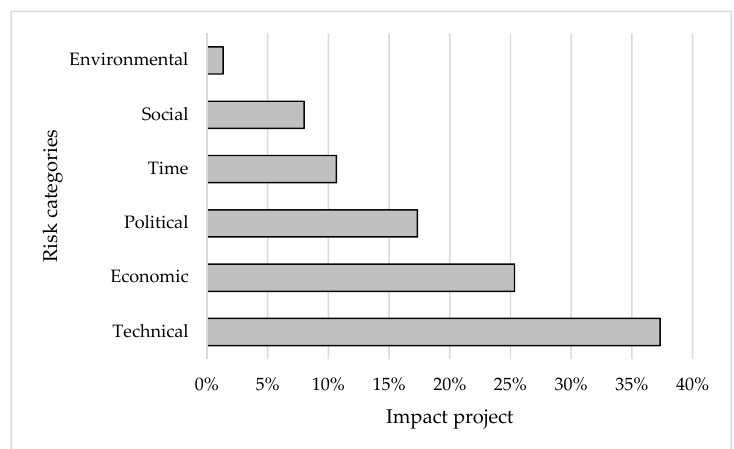
Figure 4. Incidence of nodes by risk category.